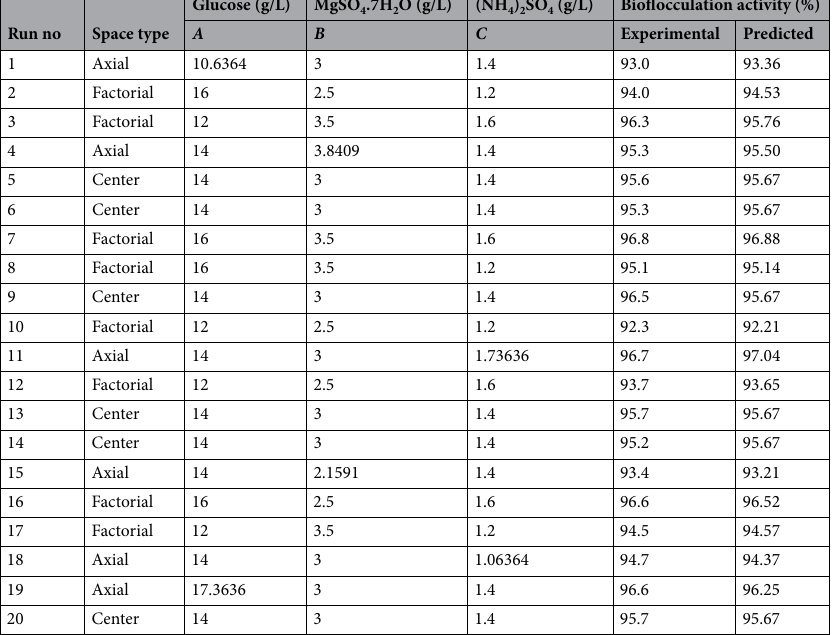
Table 4. Central composite design (CCD) matrix with the experimental and predicted bioflocculation activities.